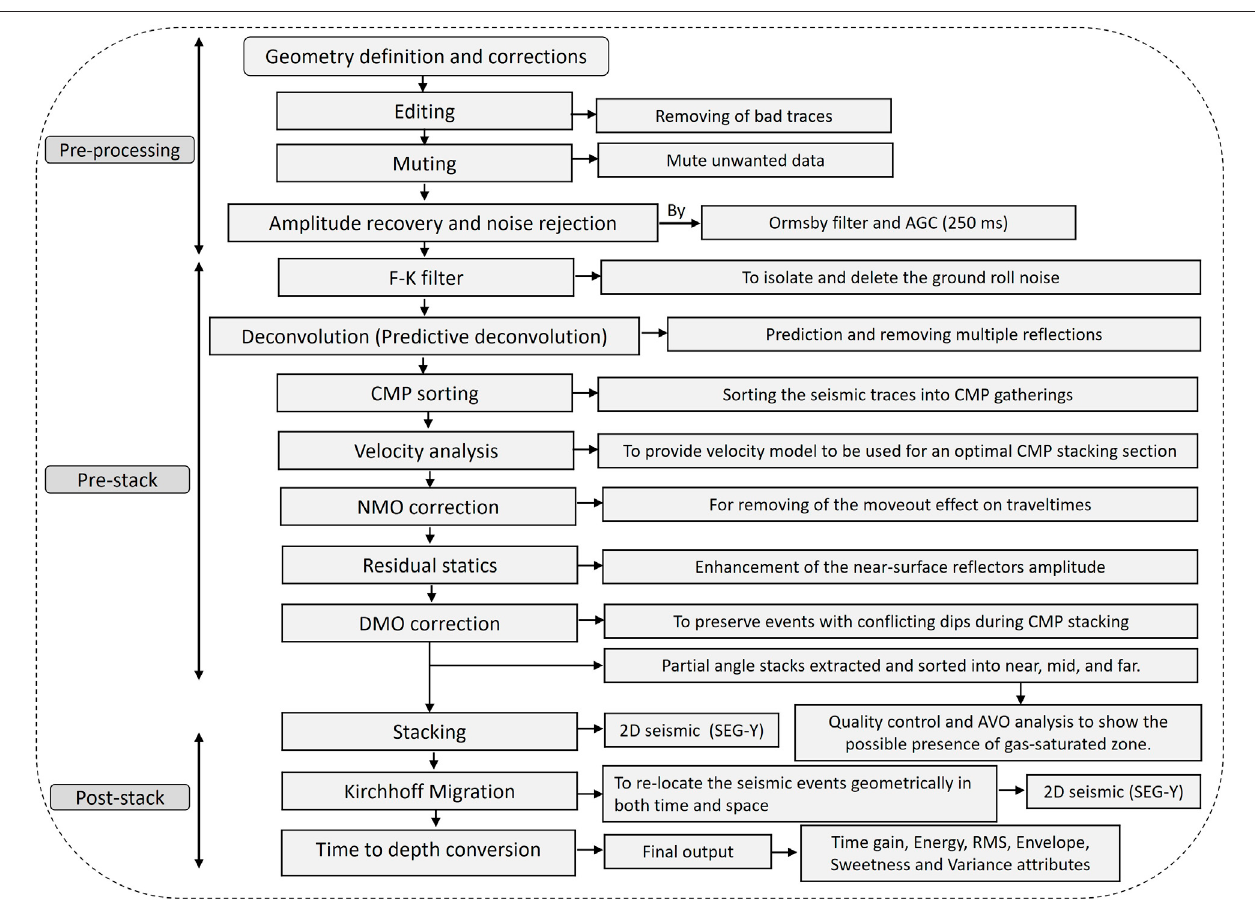
FIGURE3| Thedataprocessingwork fl owusedinthisstudyshowsthepre-processing,mainprocessing, conventional,and unconventionalseismicinterpretation sequence (Ismail et al., 2020a).